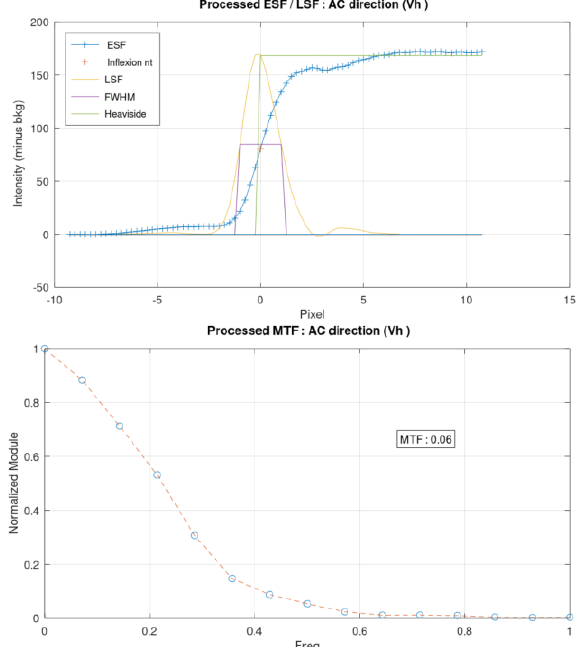
Figure 5. The ESF, LSF, FWHM, SNR, RER and MTF results over the Vh direction (across-track) from the pan band in